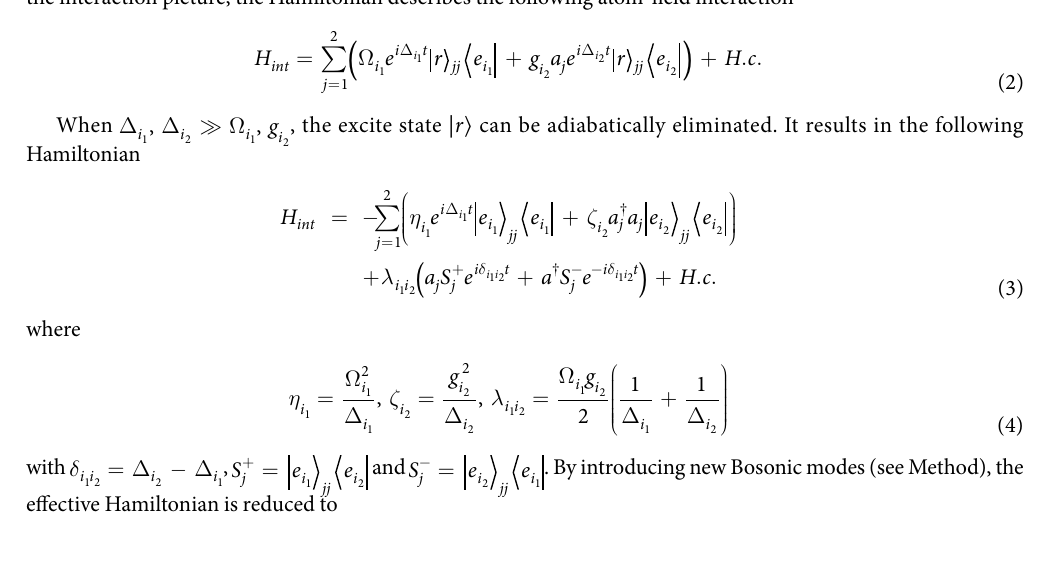
to show the possibility of these schemes, all the adiabatic conditions are considered. The numerical simulations show that our elementary gates are insensitive to the cavity decay, fiber loss, and atomic spontaneous emission. These gates can be constructed with high fidelity by choosing the parameters appropriately.